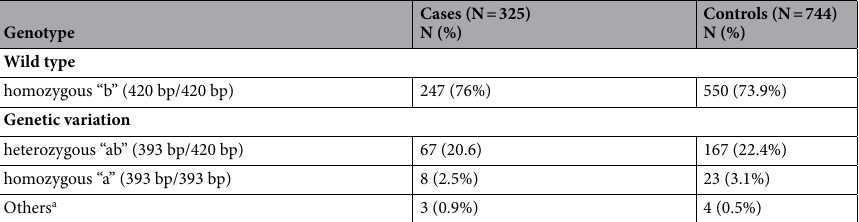
Table 2. Distribution of wild type and polymorphic alleles of e-NOS intron 4 VNTRs polymorphism across cases and controls. a Others group included the following genetic variations: 420 bp/447 bp (3 cases and 2